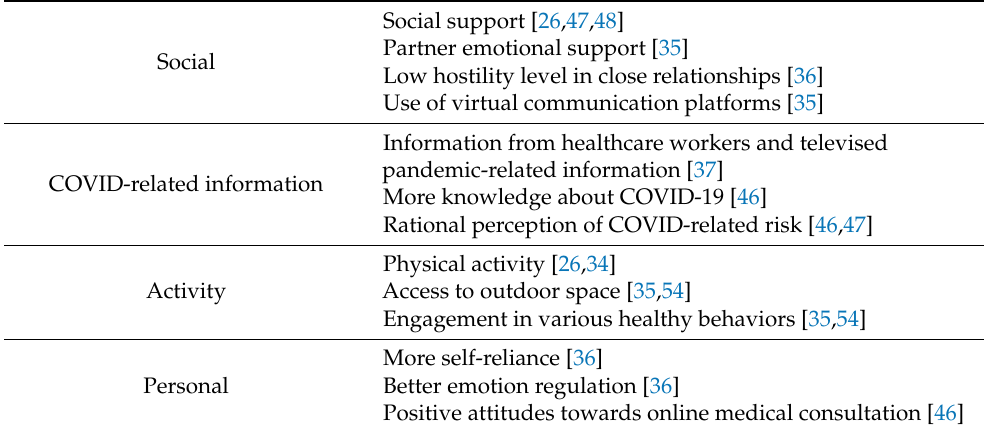
Table 4. Protective